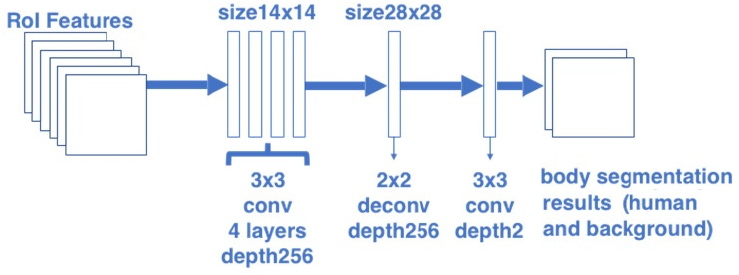
Figure 3. Architecture of the body segmentation branch.